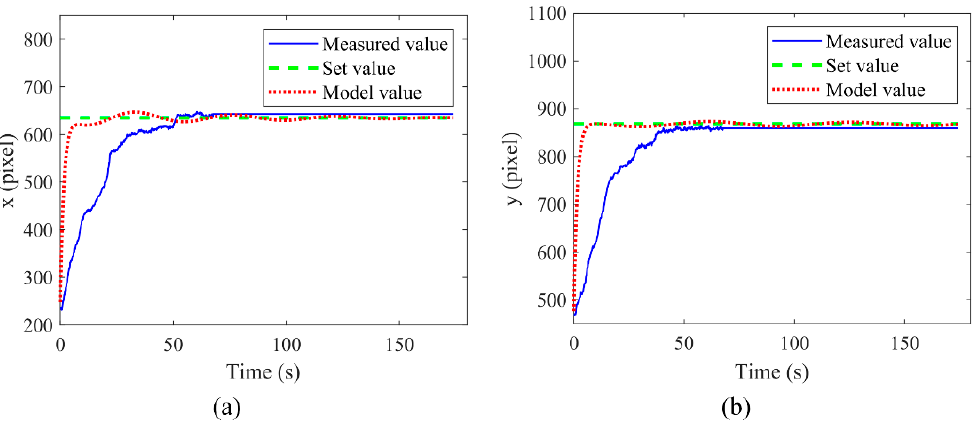
Figure 7. Diagrams of the model output and the actual output at the x-axis ( a ) and the y-axis ( b ), respectively.